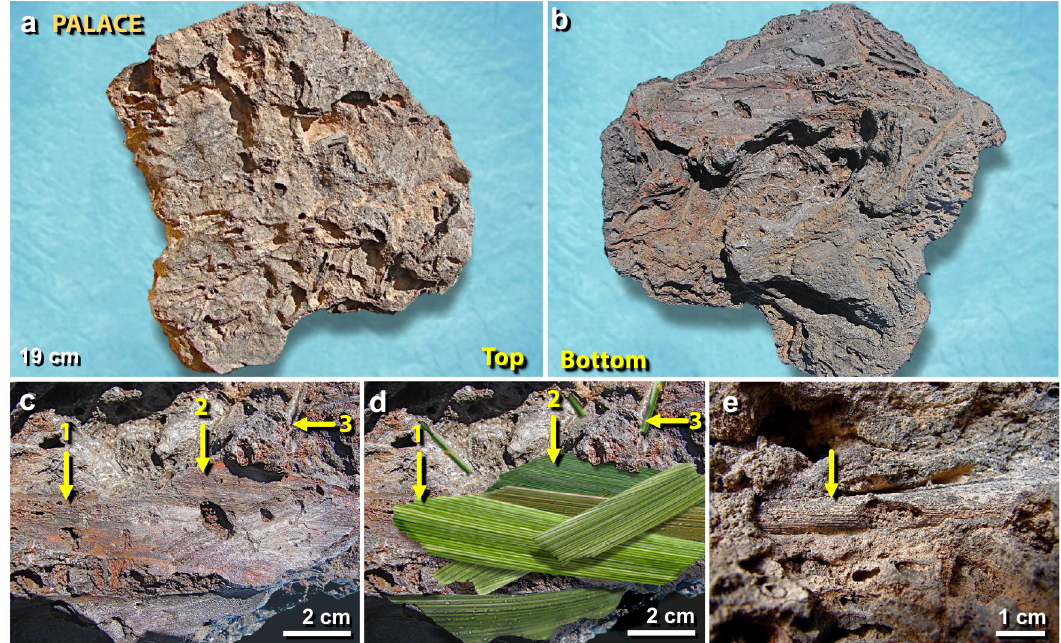
Figure 14. Plant imprints in melted roofing clay from the palace. ( a ) The upper surface of a 19-cm-wide piece of roofing clay, melted and distorted at high temperatures; ( b ) lower surface of the same object, showing imprints of silicified plant material; ( c ) closeup of the lower surface with numbered yellow arrows pointing to ribbed imprints of leaves pressed into the bottom of roofing clay (#1 through #3); ( d ) artist’s depiction, re-creating possible leaf structures before combustion; ( e ) yellow arrow points not to a plant imprint, but rather to a cylinder-like silica-rich pyromorph of plant stem embedded in roofing clay. From the destruction layer in the palace (Field UA, Square